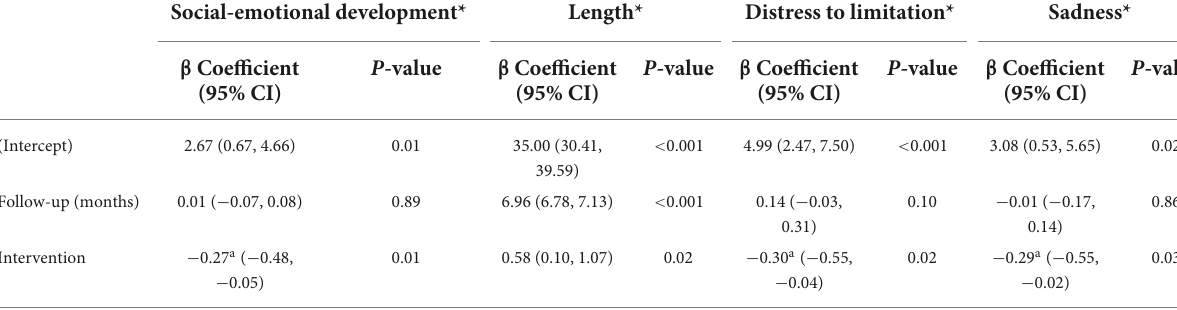
TABLE 3 Mixed effects model for social-emotional development, length, distress to limitation, and sadness over the 6-month follow-up period. Social-emotional development* Length* Distress to limitation*